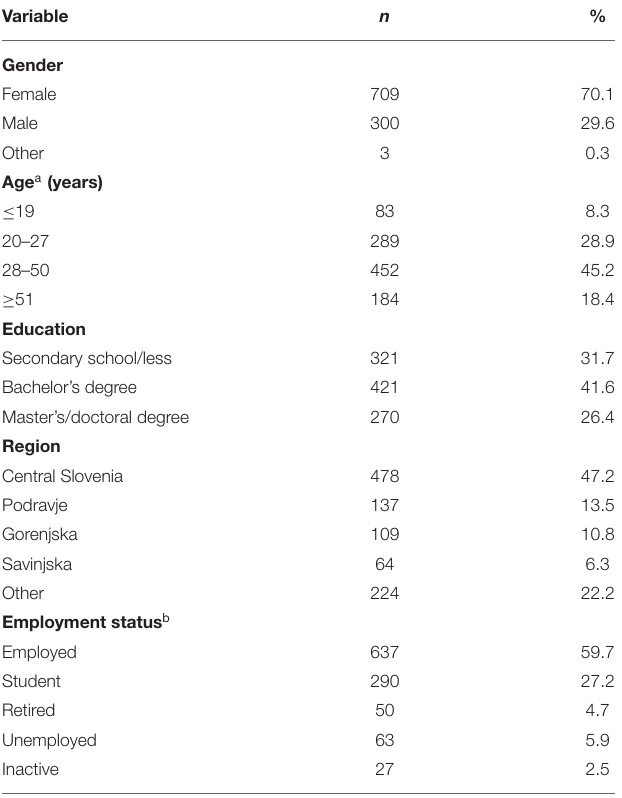
TABLE 1 | Demographic characteristics of lay